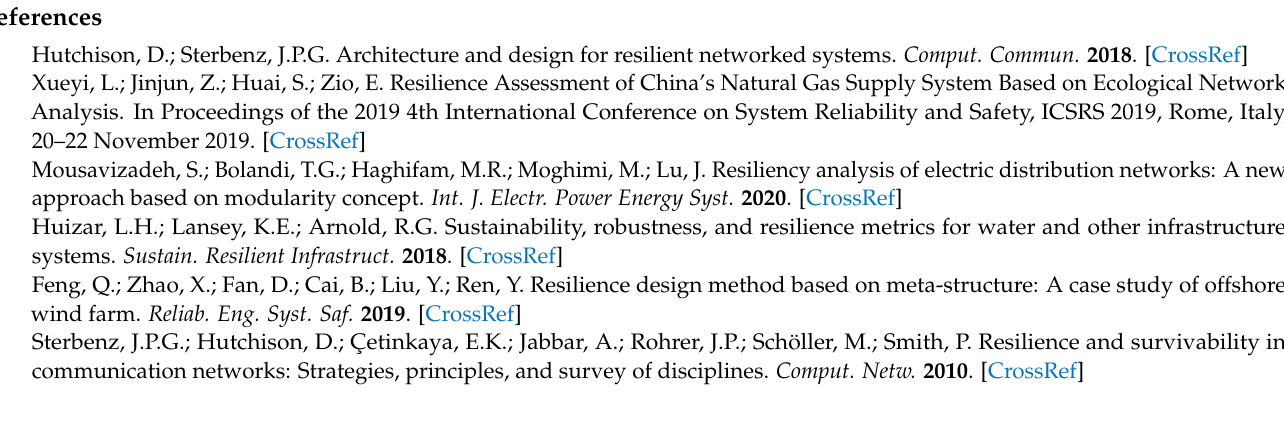
Figure 13. Resilience indexes in drilling sub-fleets with the addition of an additional piece of equipment.